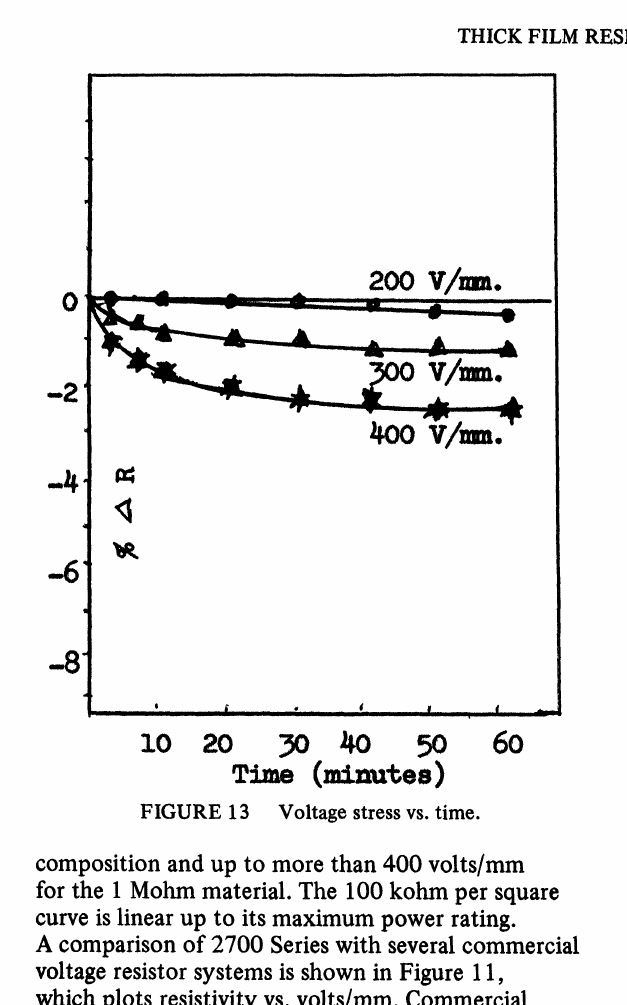
FIGURE 13 Voltage stress vs. time. composition and up to more than 400 volts/mm for the Mohm material. The 100 kohm per square curve is linear up to its maximum power rating. A comparison of 2700 Series with several commercial voltage resistor systems is shown in Figure 11, which plots resistivity vs. volts/mm. Commercial resistor A (2 Mohm) and 2716 were linear